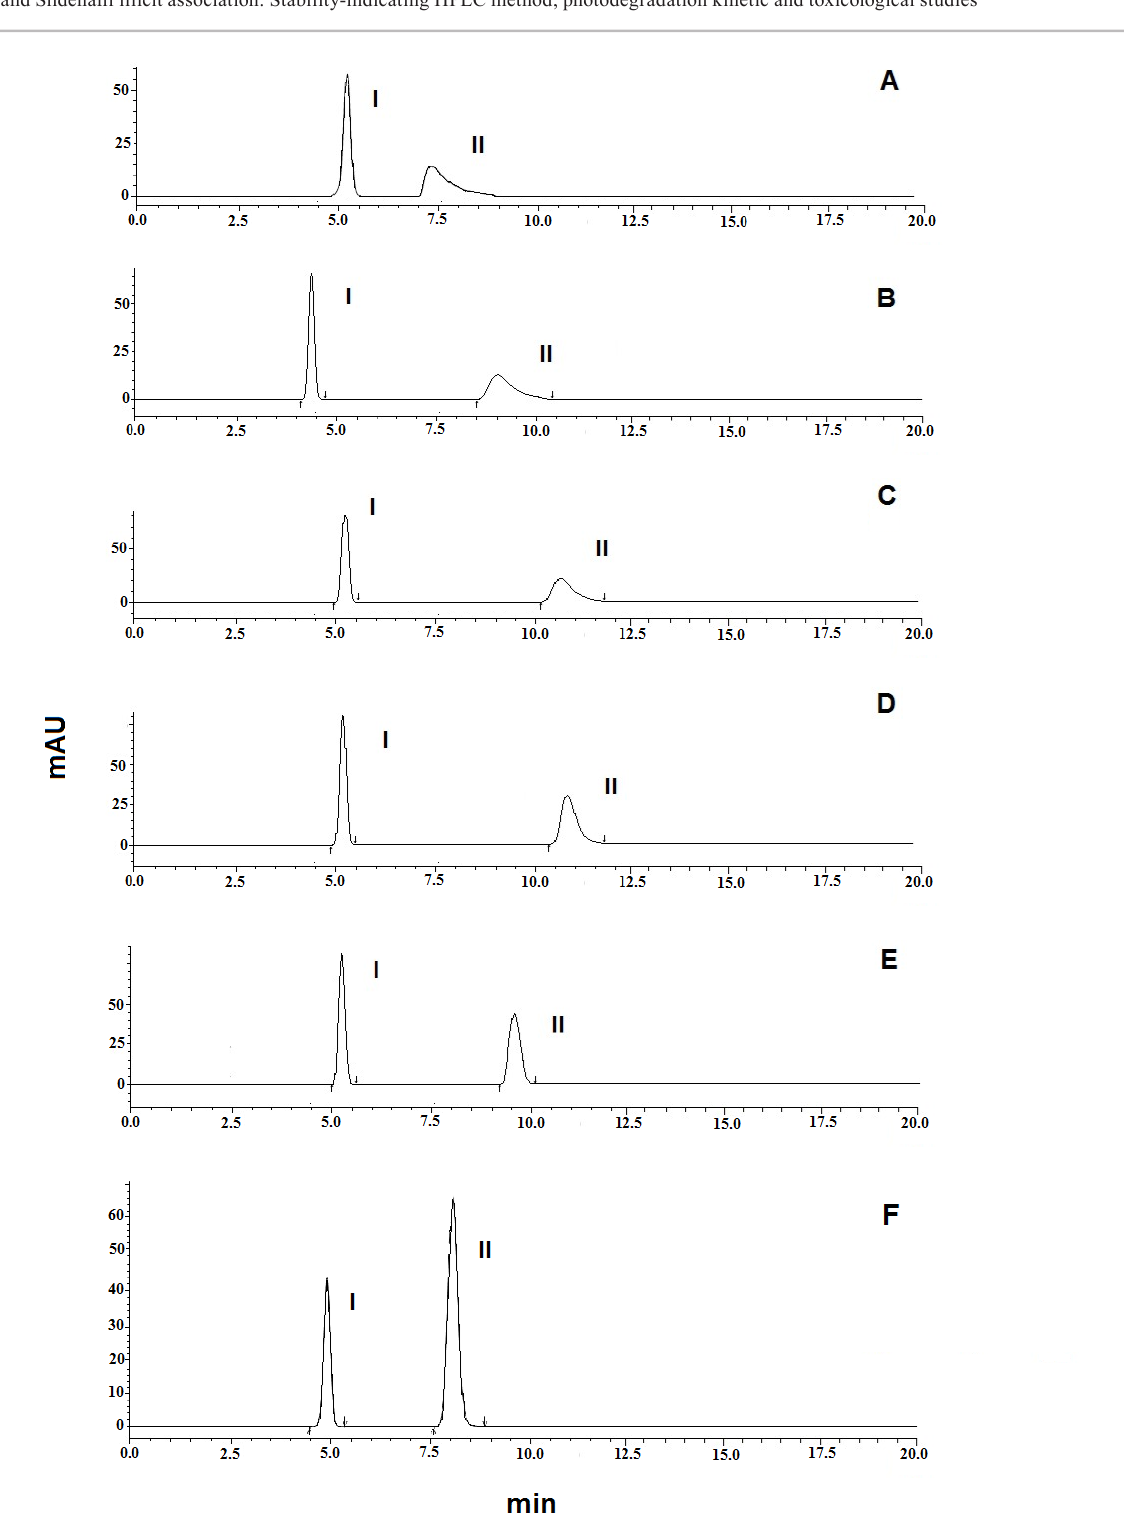
FIGURE 2 - Chromatograms obtained for TAD (I) and SIL (II) in method development with different mobile phases, where: ( A ) methanol:water (70:30, v/v); ( B ) acetonitrile:water pH 3.0:methanol (30:30:40, v/v); ( C ) acetonitrile:water pH 4.0:methanol (30:30:40, v/v); ( D ) acetonitrile:water pH 5.0:methanol (30:30:40, v/v); ( E ) acetonitrile:water pH 7.0:methanol (30:30:40, v/v); ( F ) solution A:Solution B (30:70, v/v); Solution A is composed of acetonitrile:water (80:20, v/v) and solution B of methanol:triethylamine 0.3% pH 7.5 (57:43, v/v). Detection was performed at 284